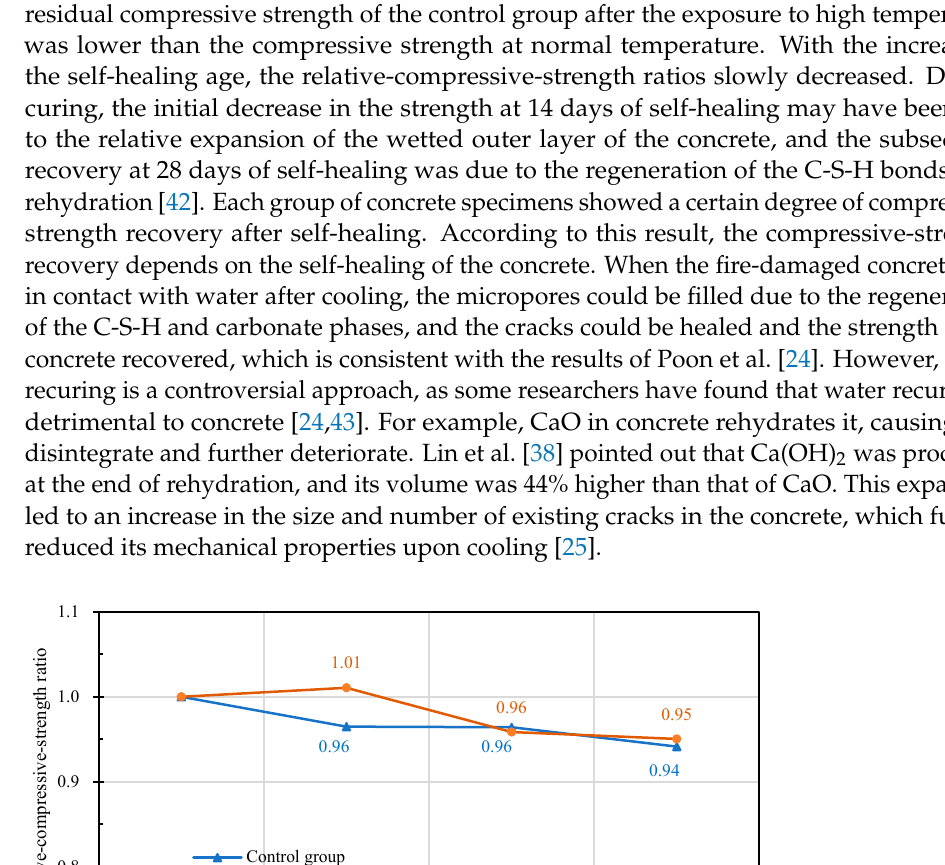
( b ) Figure 21. Destruction appearance of the concrete specimens after flexural test at room temperature: ( a ) control group; ( b ) experimental group. Table 17. Results of flexural test of the concrete at room temperature. Concrete Group